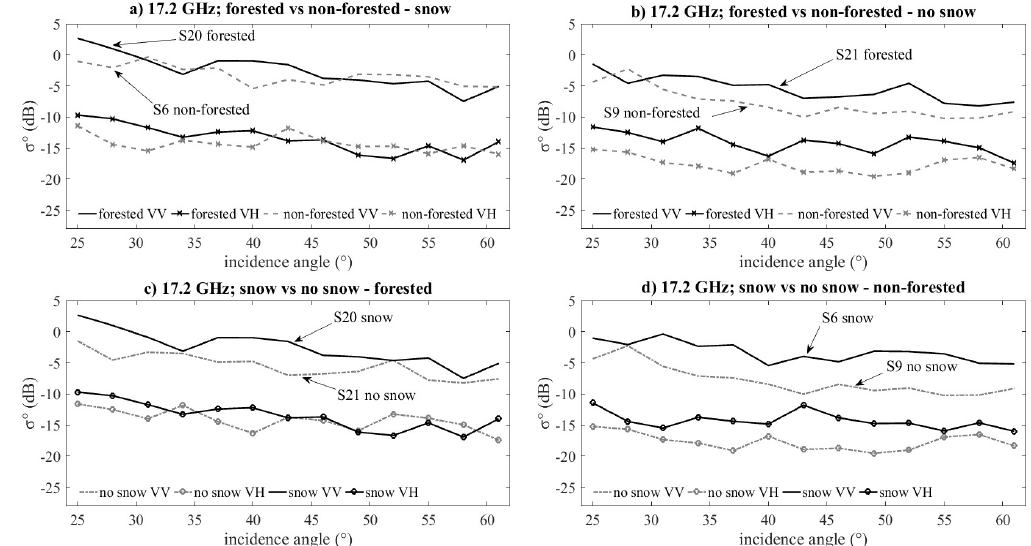
Figure 6. Comparison of 17.2 GHz backscatter response (VV and VH) as a function of the incidence angle at the Trail Valley Creek (TVC) and Grand Mesa sites. TVC sites 6 (non-forested [S6]) and 20 (forested [S20]) and sites 9 (non-forested [S9]) and 21 (forested [S21]). The figures compare the 17.2 GHz responses between the forested and non-forested sites for the ( a ) snow and ( b ) no snow cases. Also shown are the 17.2 GHz responses between the snow and no snow sites for the ( c ) forested and ( d ) non-forested cases at TVC.